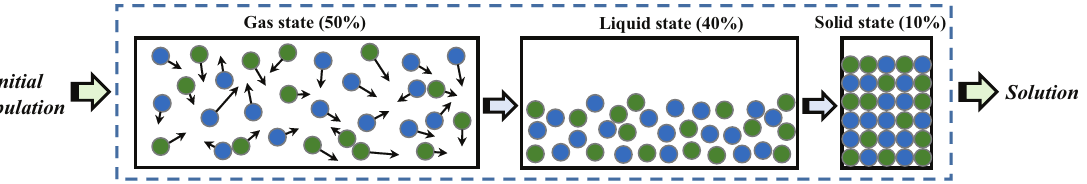
Figure 3. Evolutionary process of the SMS